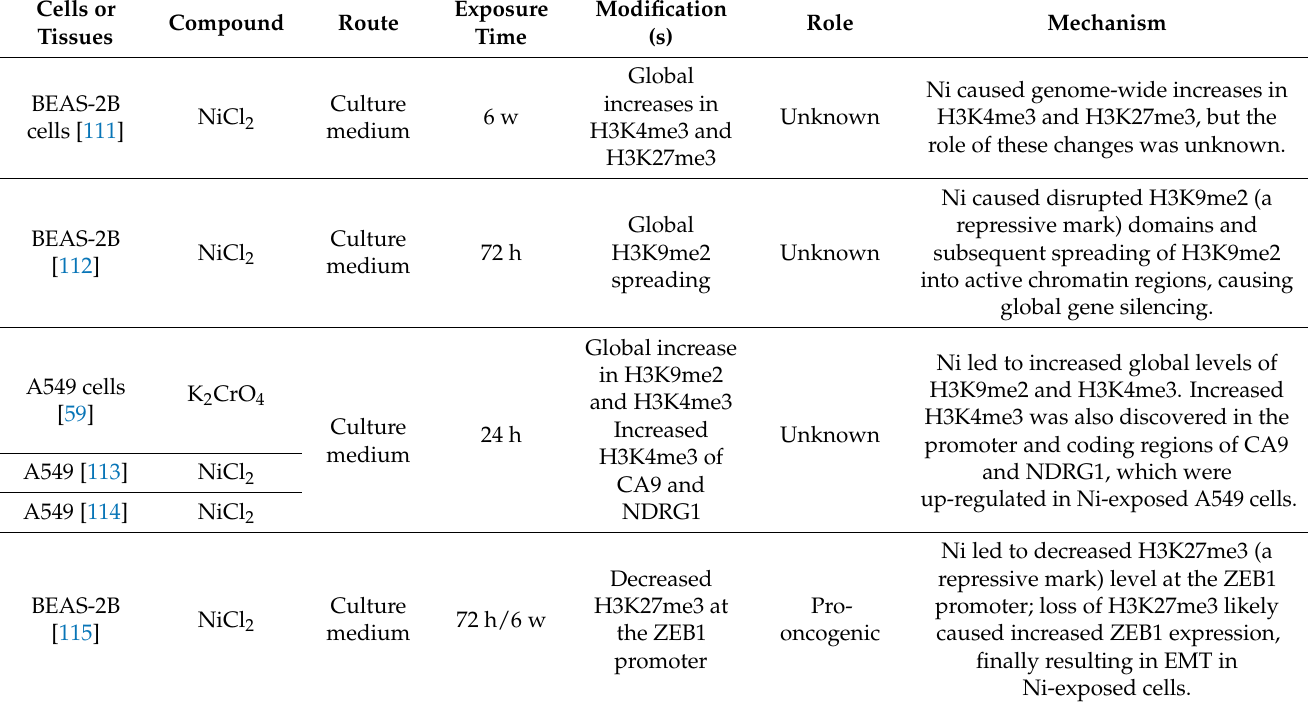
Table 5. Roles of altered histone modifications in Ni exposure-induced carcinogenesis. Cells